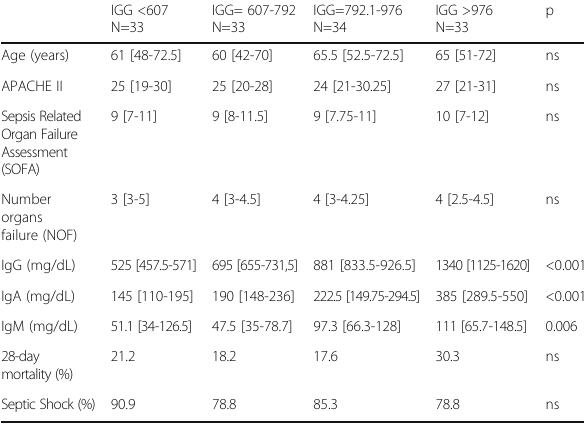
Table 50 (abstract A133). Characteristics Sever Sepsis/Septic Shock